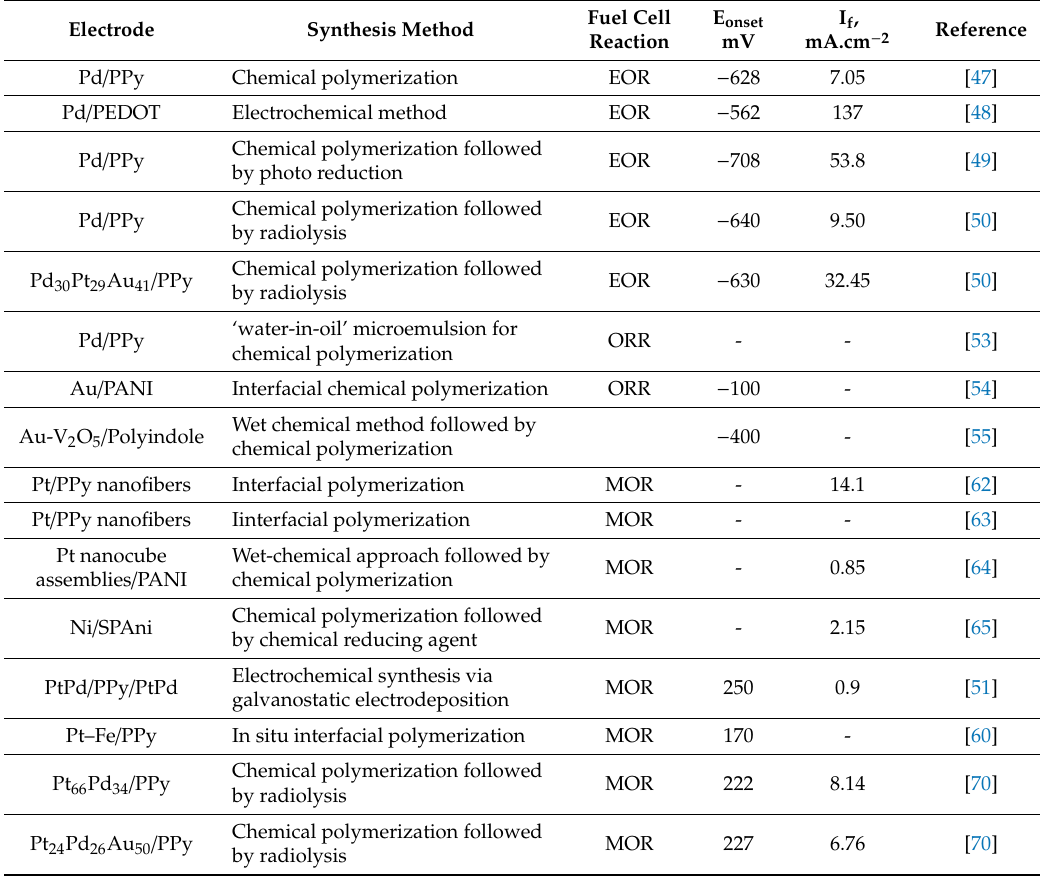
Table 1. Conducting polymer-based nanohybrid materials and their applications in electrocatalysis. Electrode Synthesis